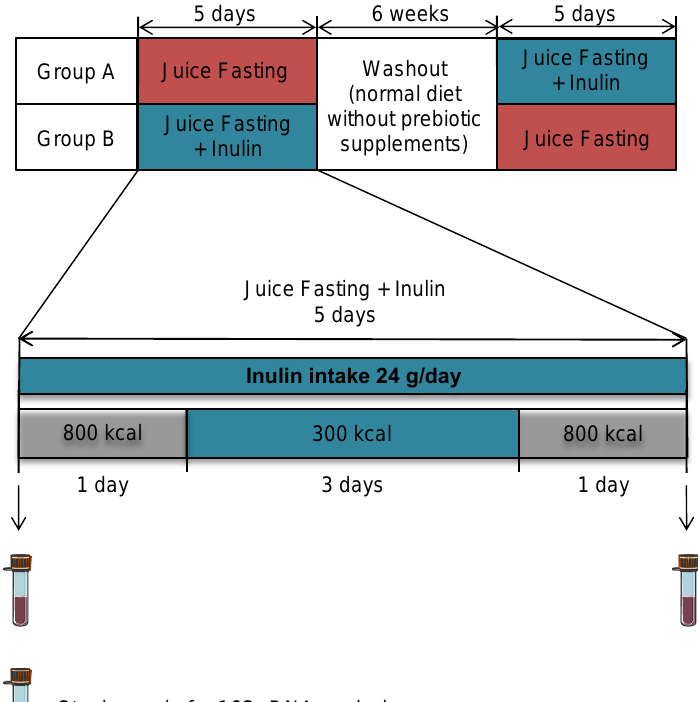
Figure 1. Study design of the crossover intervention. Two juice fasting interventions (one with additional 24 g inulin taken daily and one without inulin) separated by a six-week washout phase. Each fasting intervention consisted of five days. The first and the last day each included small light meals of 800 kcal in total. The three acute fasting days in the middle of the intervention include 300 kcal daily as vegetable juices and tea. Stool samples were collected right before and after each fasting intervention.